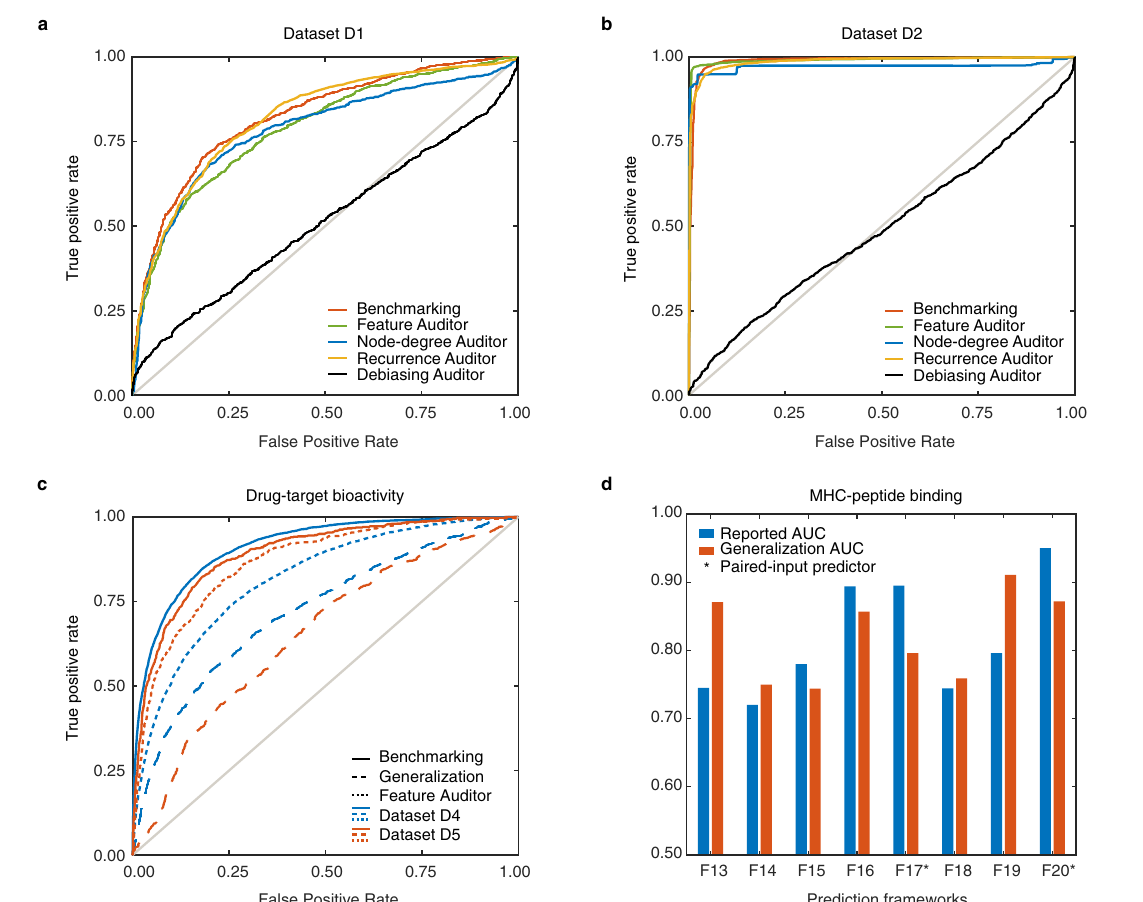
Fig. 2 Auditing three paired-input applications of therapeutic interest. a The performance of the best performing PPI classi fi er, F1, on dataset D1 for benchmarking and the four auditors. In the Feature Auditor, protein features are masked; yet, classi fi er performance is retained. In the Node-degree and Recurrence Auditors, proteins are represented solely by their node degrees in the positive or negative training dataset or by their differential node degree between the positive and negative training examples; yet, without protein features, classi fi er performance informed by node degree or protein recurrence alone is retained. b The performance of the best performing PPI classi fi er, F5, on dataset D2, with similar observations as with Fig. 2a. c The performance of the optimized drug-target predictor F8 on datasets D4 and D5 in the benchmarking (module 1), generalization (module 2), and bias identi fi cation (module 3, Feature Auditor). d The reported (module 1) and generalization (module 2) performances of MHC-peptide binding predictors F13 – F20. Asterisks denote the two paired-input predictors, F17 and F20; the other predictors are